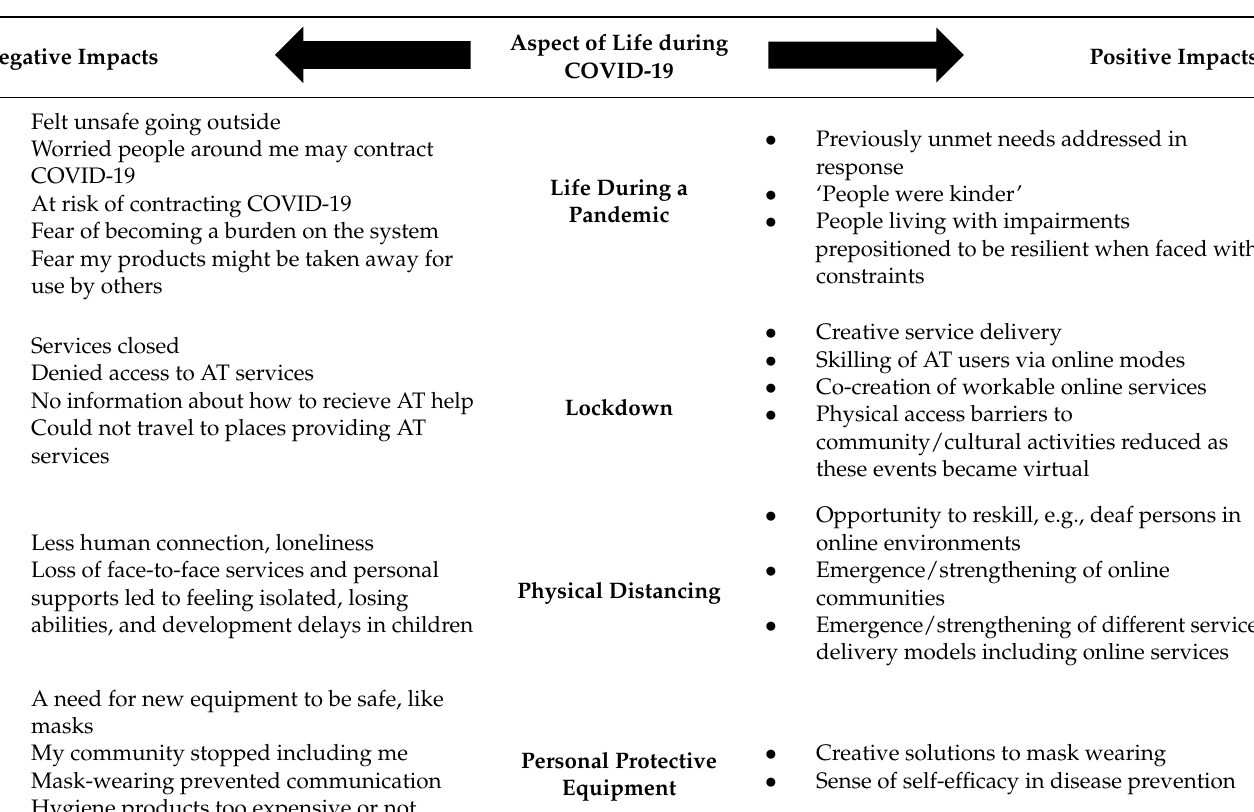
Table 1. Impacts of restrictions.